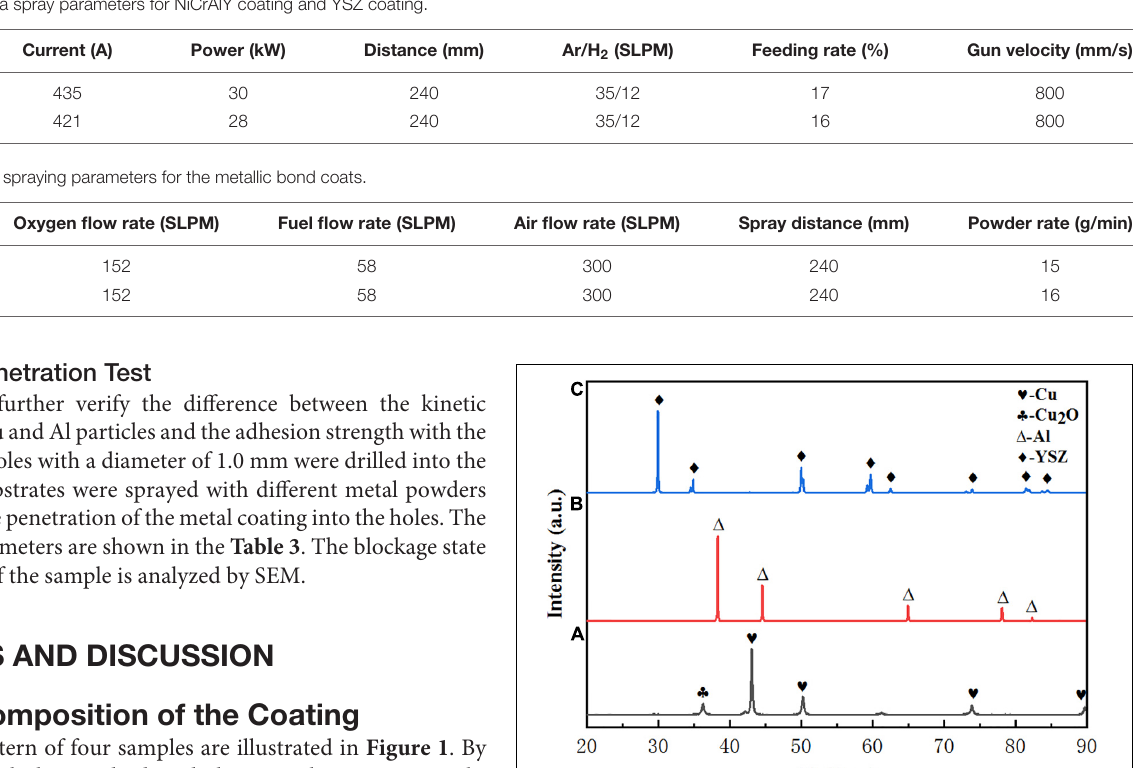
TABLE 2 | Plasma spray parameters for NiCrAlY coating and YSZ coating.